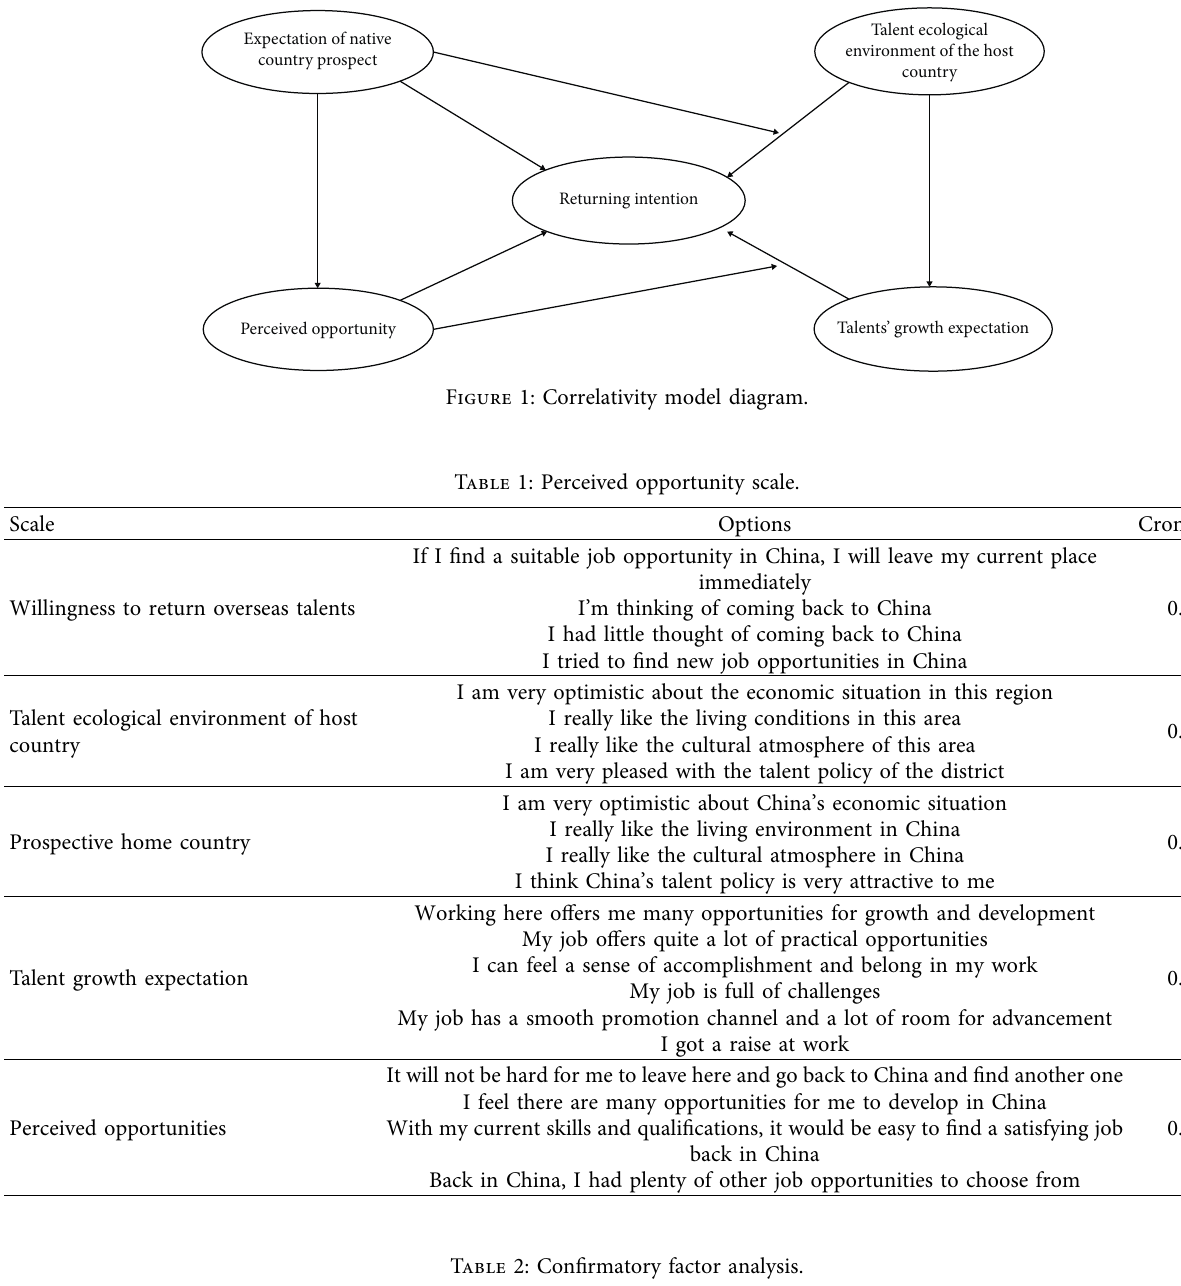
Table 2: Confirmatory factor analysis.